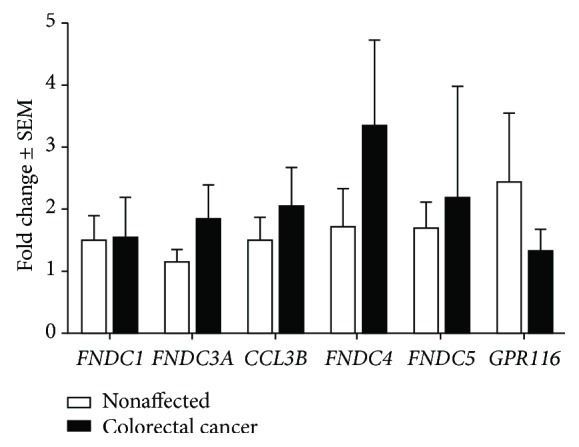

FNDCs and GPR116 expression in colorectal cancer. No significant expression differences were found in a paired-sample t-test analysis for any of the investigated genes between cancerous samples and the surrounding nonaffected samples (n = 8-10).